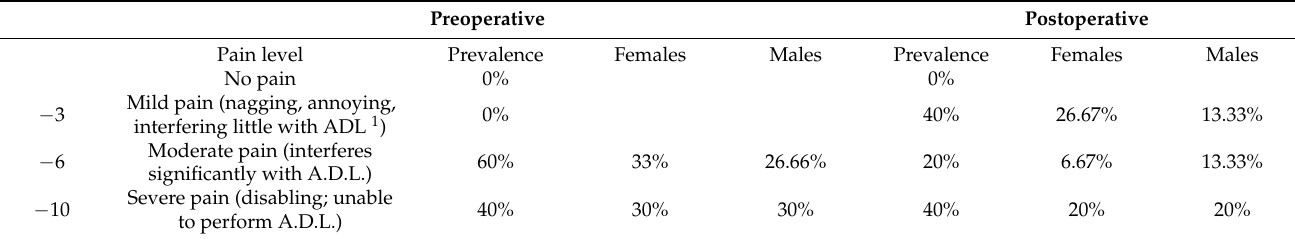
Table 1. Prevalence of pain level between males and females influencing activities of daily living before and after